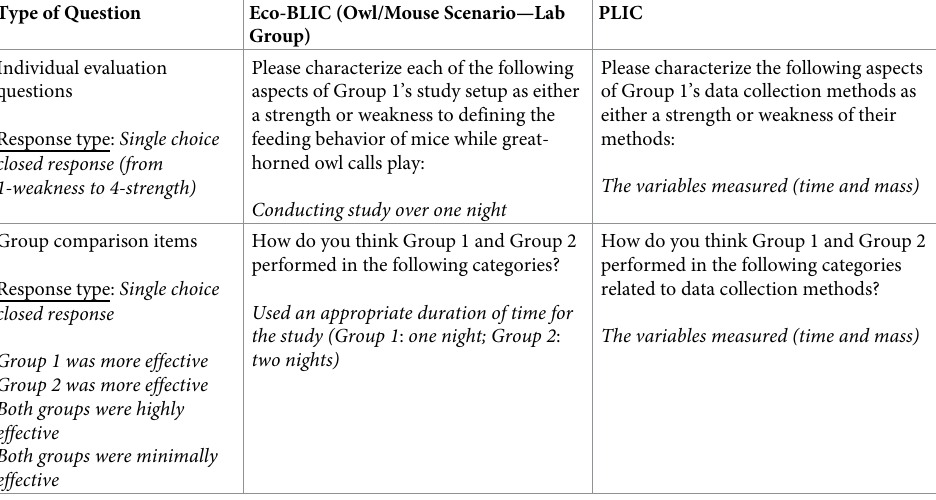
Table 2. Examples of individual evaluation and group comparison items on the Eco-BLIC and